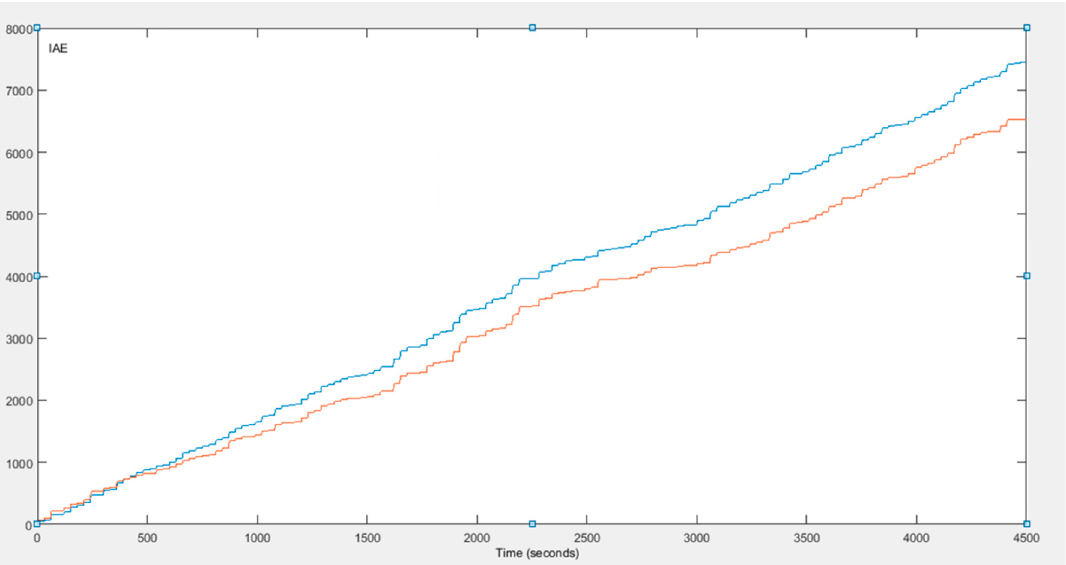
Figure 6. IAE of conventional PID control strategy (blue line) and fuzzy Q-Learning PID control strategy (red line).